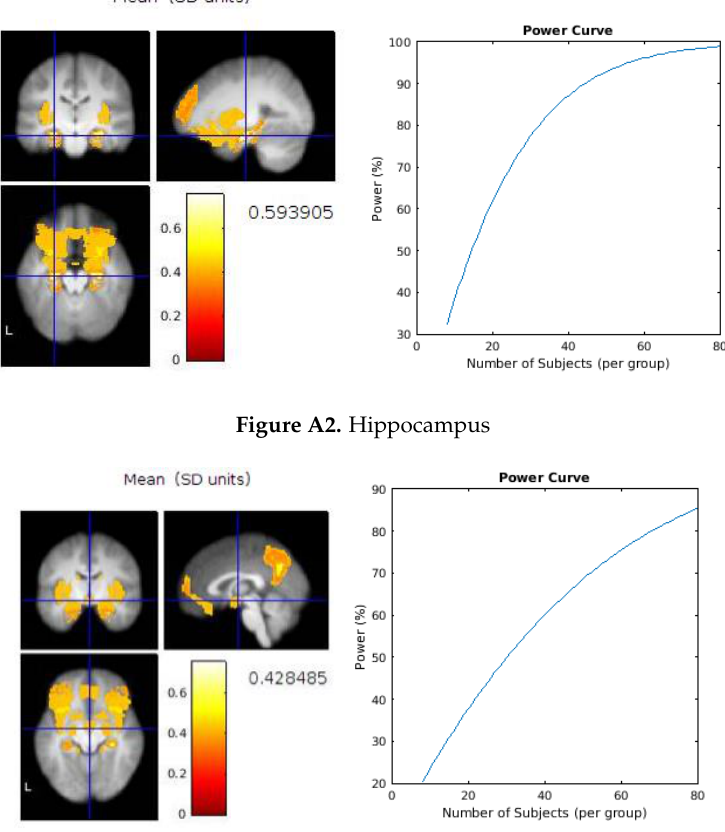
Figure A3. Figure B2 . Hypothalamus.